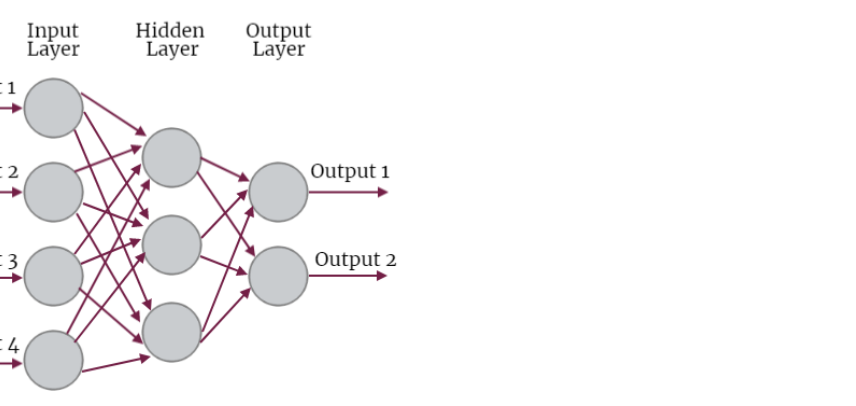
Figure 5. A generalized illustration of the modifications present in a deep residual network building block using identity bypass.